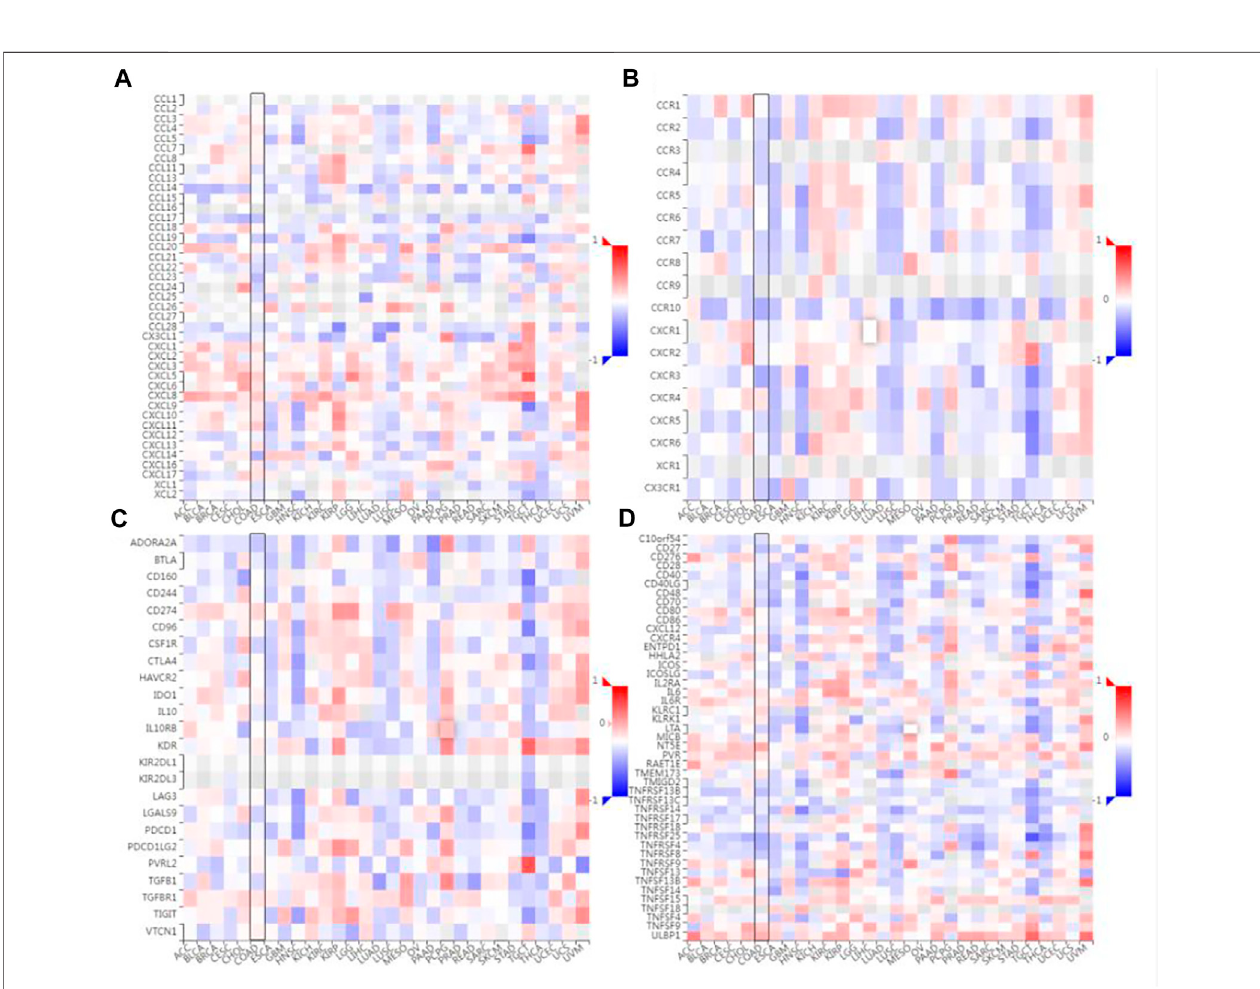
FIGURE 6| Correlation analysisbetween SLC7A11 expression and immunomodulators or chemokinereceptors. (A) Heatmap analysis ofthe correlation between SLC7A11andchemokinesintumors. (B) HeatmapanalysisofthecorrelationbetweenSLC7A11andchemokinereceptorsintumors. (C) CorrelationbetweenSLC7A11 and immunoinhibitors in tumors via heatmap analysis. (D) Correlation between SLC7A11 and immunostimulators in tumors by heatmap analysis.